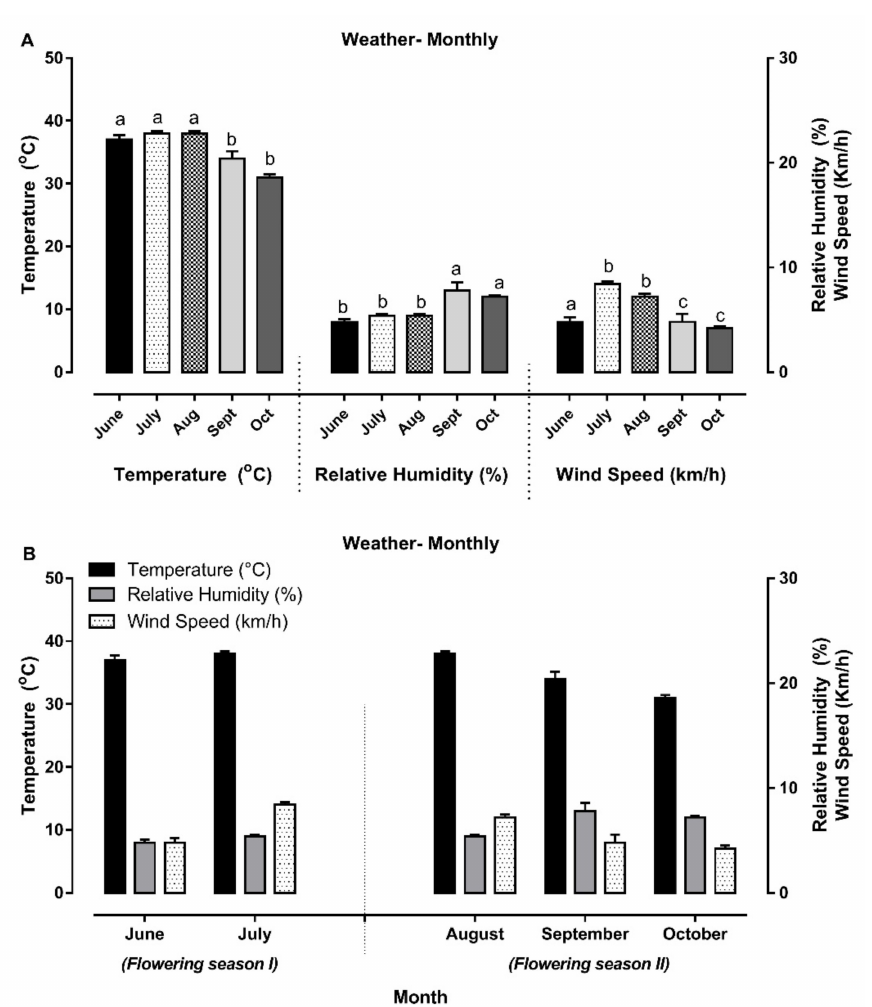
Figure 2. Monthly pattern of meteorological temperature ( ◦ C), relative humidity (%) and wind speed (km/h) data recorded during the flowering seasons of Z. nummularia in central Arabia. ( A ) Monthly patterns of weather factors (mean ± SEM). ( B ) Comparison of weather factors among different months (mean ± SEM). Different letters indicate significant differences among monthly weather data within a group of single weather factors at p < 0.05. SEM: standard error of the mean.